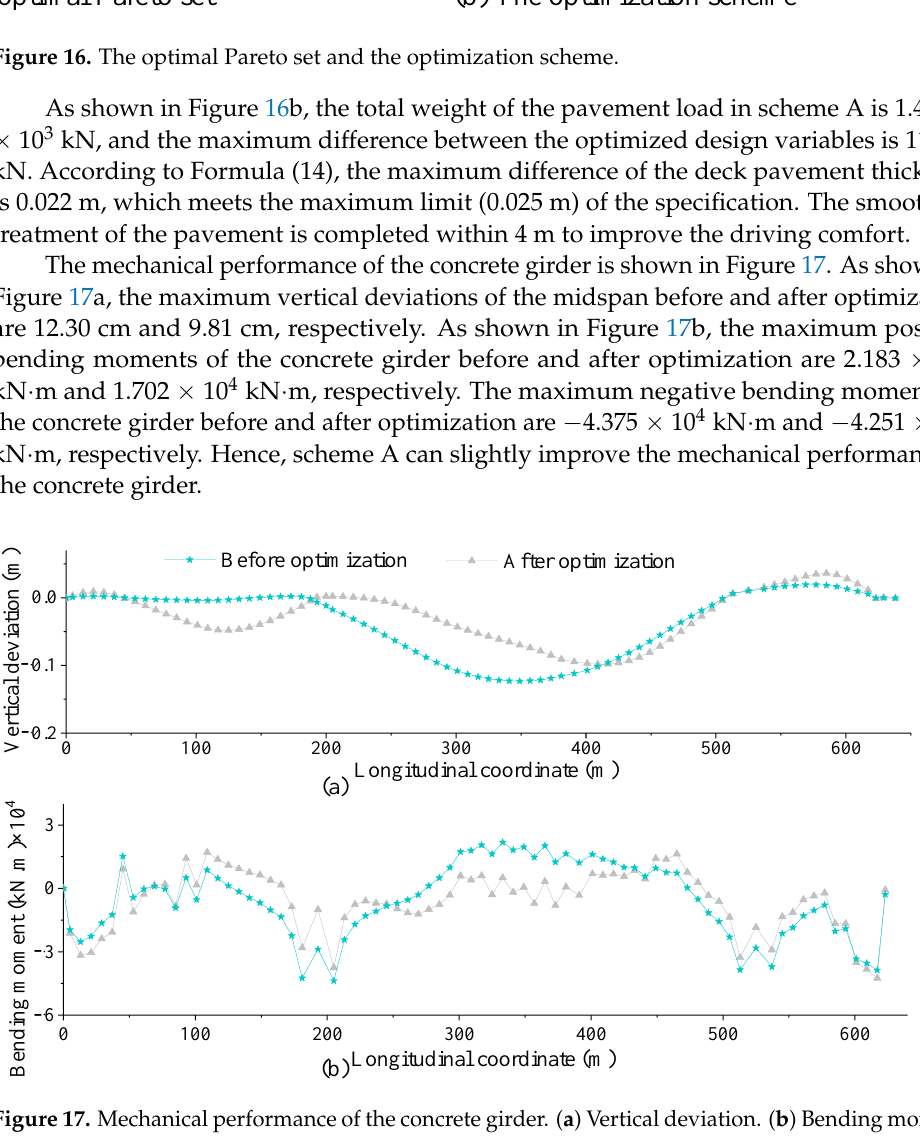
Figure 17. Mechanical performance of the concrete girder. ( a ) Vertical deviation. ( b ) Bending moment. As shown in Figure 18, the bending moment and longitudinal displacement of the pylon are almost unchanged after optimization, which means that scheme A hardly changes the mechanical performance of the pylon. As shown in Figure 19, the maximum deviation of the cable tension before and after optimization does not exceed 1%, which further indicates that the mechanical performance of the structure is not changed. Hence, scheme A is feasible to control the NRRAP under the live load. Figure 18. Mechanical performance of the high pylon. ( a ) Bending moment. ( b ) Longitudinal dis- placement.